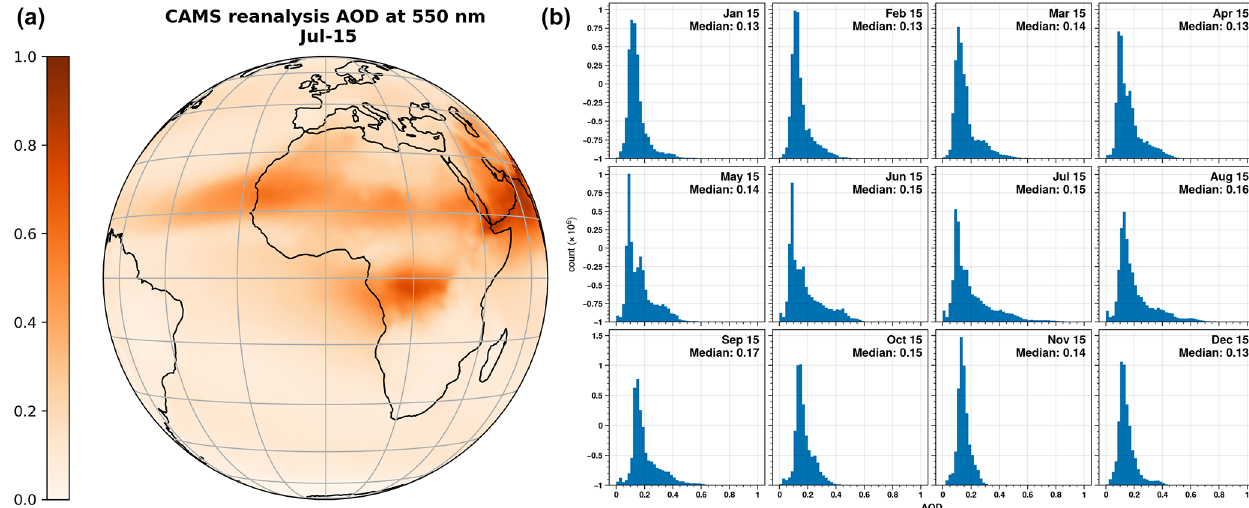
Figure 2. Long-term average aerosol optical depth (AOD) used in MDAL v2 processing, based on CAMS reanalysis (monthly values, linearly interpolated between the 15th of each month to obtain daily values). (a) Full-disk AOD for 15 July. (b) Histograms of full-disk AOD fields for the 15th of each